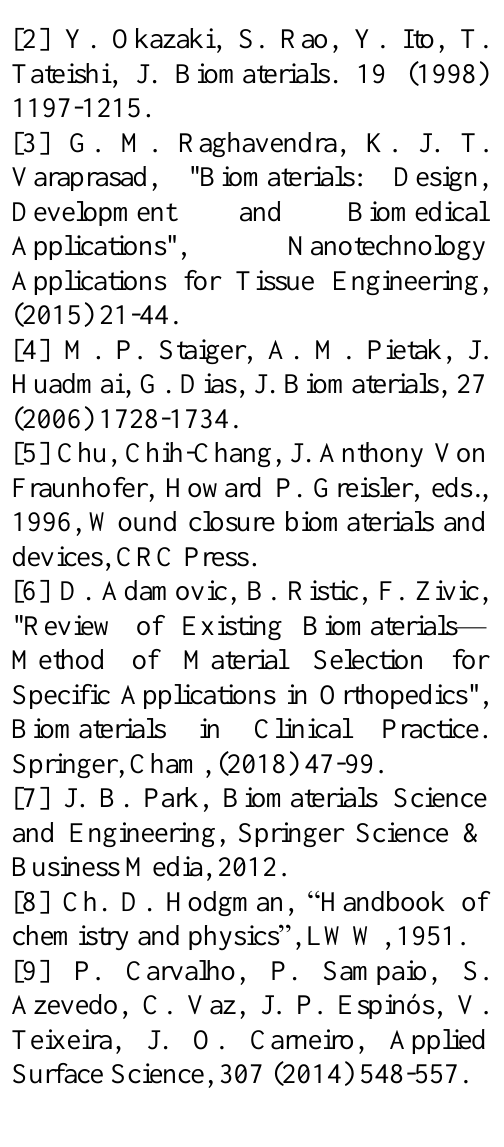
Fig. 8: The XRD pattern for the sample, which show a hydroxyapatite